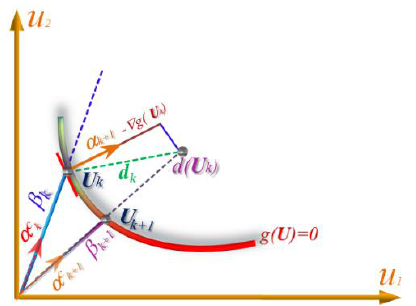
Figure 1. Schematic illustration of the iterative process of the CFORM algorithm.